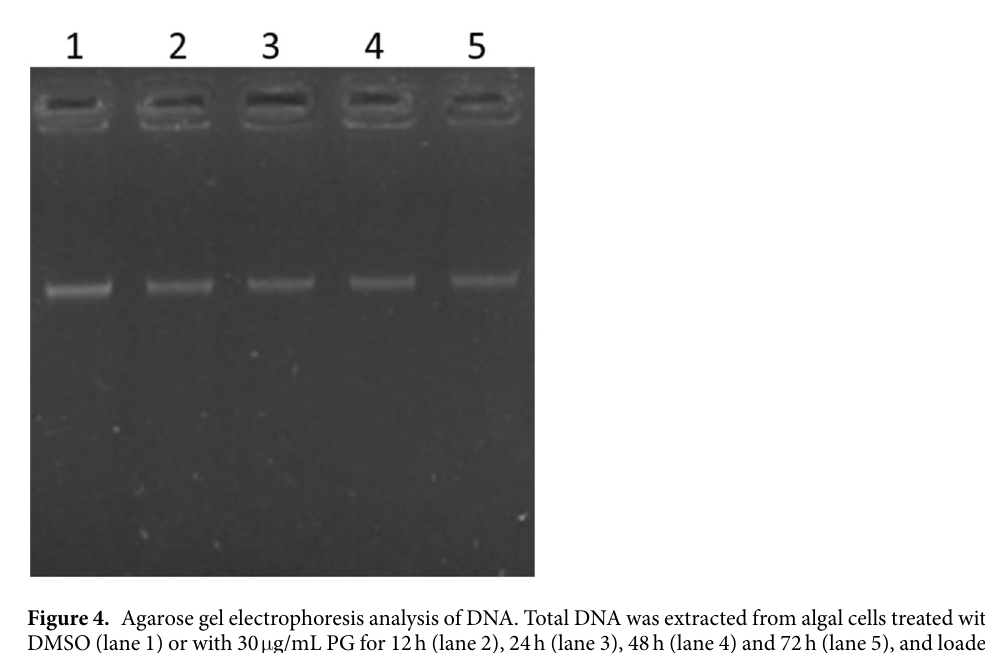
Figure 3. Flow cytometry analysis of cell membrane integrity. PG-treated M. aeruginosa cells (30 μ g/mL) stained with propidium iodide (PI) and Annexin V-fluorescein.